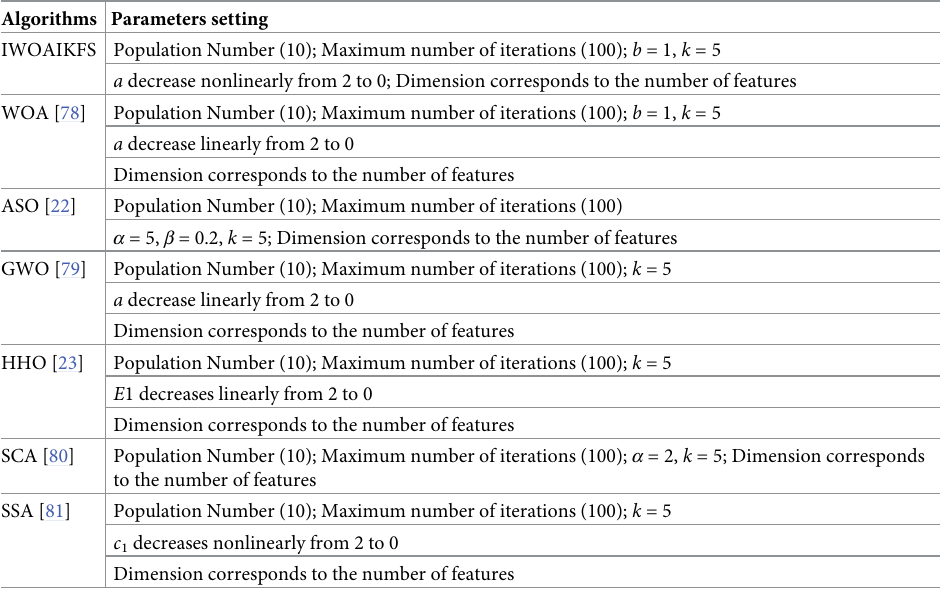
each algorithm for 30 independent experiments under 15 datasets. Under 30 independent experiments on 15 datasets, the comparison of IWOAIKFS between other optimizers is shown in Table 10: